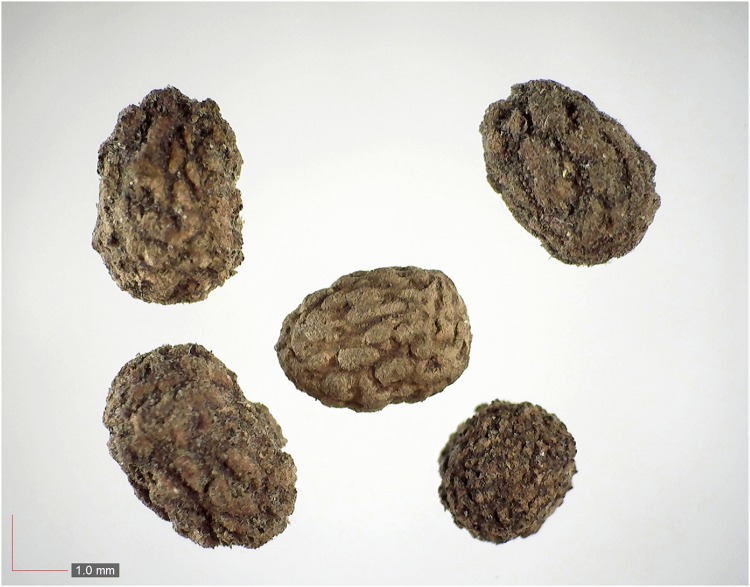
Unidentified 9.Table 2.